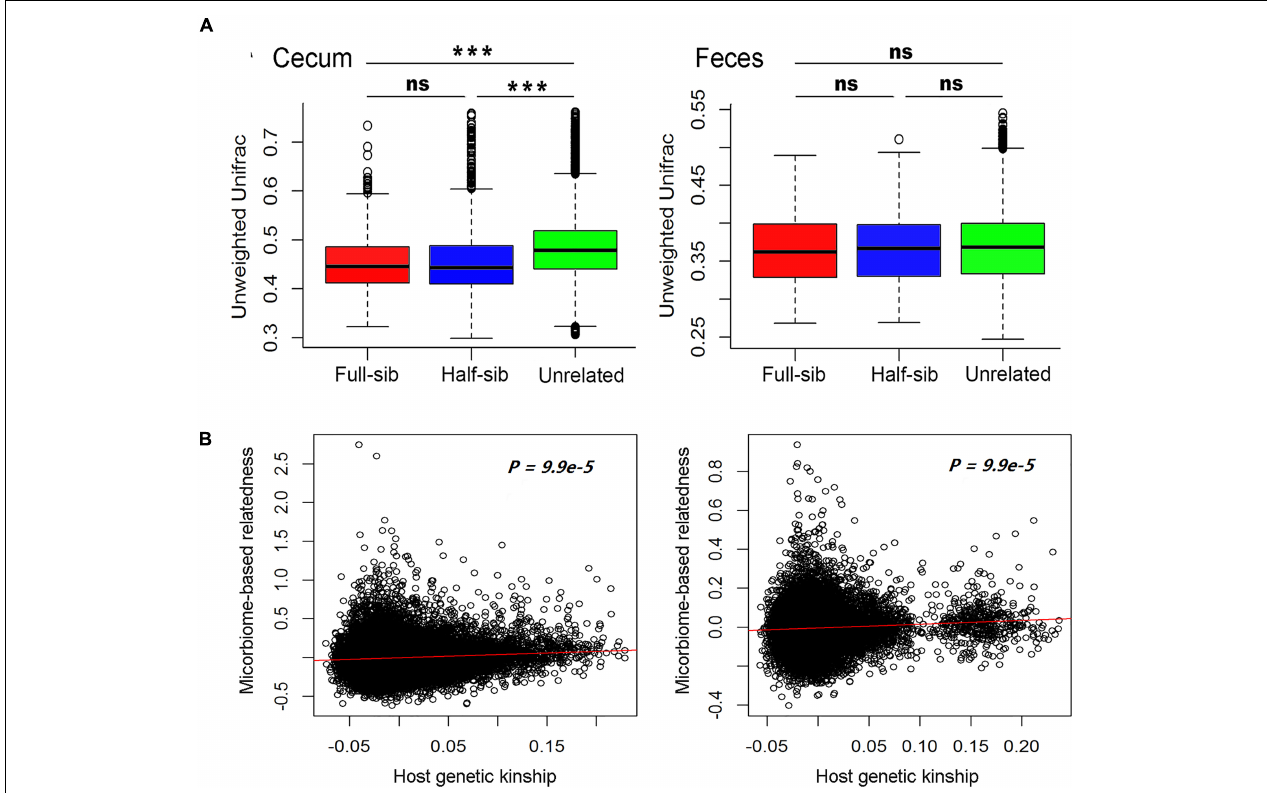
FIGURE 3 | Host genetic effect on microbial compositions of cecum lumen and feces. (A) Comparison of the phylogenetic diversity of microbial composition among full-sib pairs, half-sib pairs and unrelated individuals by Unweighted Unifrac analysis. Full-sib pairs showed a higher similarity of microbial composition than unrelated individuals in both Erhualian (EHL) and Bamaxiang (BMX). The analysis was performed by QIIME (v 1.9). (B) Host genetic kinship calculated from host genome data ( x -axis) is correlated with the microbial composition-based kinship (y-axis). In the panels, solid red lines represent a linear regression fit to the